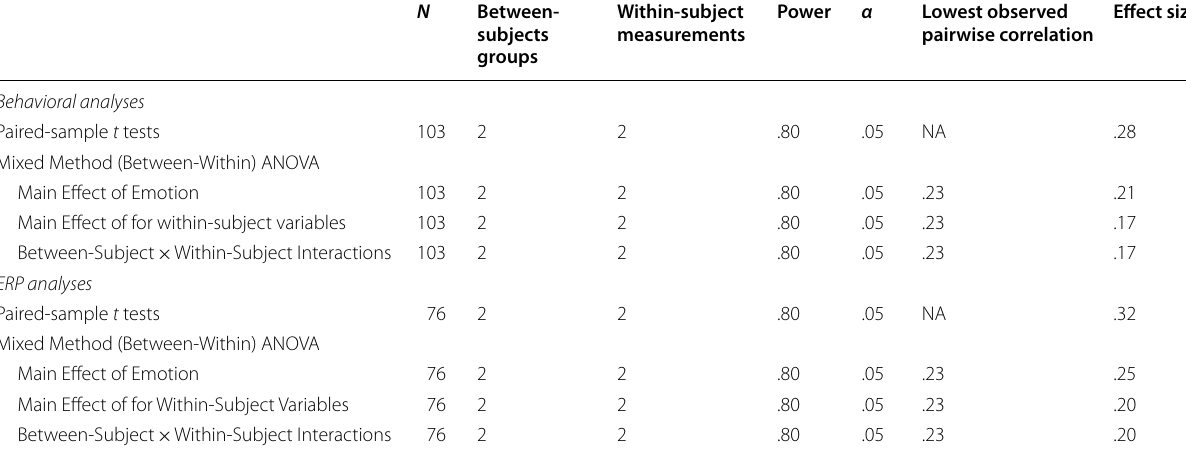
Sensitivity analyses are reported for paired‑sample t tests and mixed method ANOVAs, separately for behavioral and ERP analyses. We used the lowest observed pairwise relationship among within‑subject factors to obtain conservative estimates of the lowest effect size our analyses would be able to detect. Effect sizes for t test are reported in Cohen’s d , effect sizes for ANOVAs are reported in Cohen’s